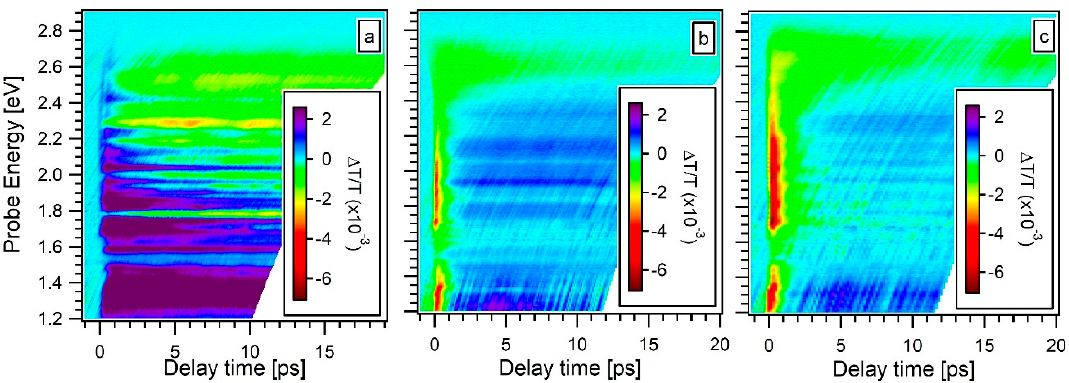
Figure 4. Transient transmittivity Δ T/T (E,t) diagrams of the AG ( a ), the 5k ( b ) and 5k@ ( c ) samples. In the inset a color scale indicates the transient transmittance intensity.